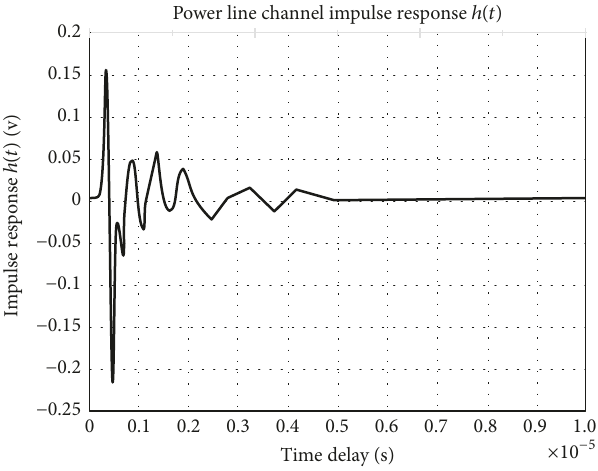
Figure 9: Impulse response of reference channel. The mean square error curve of the power line channel and the original channel